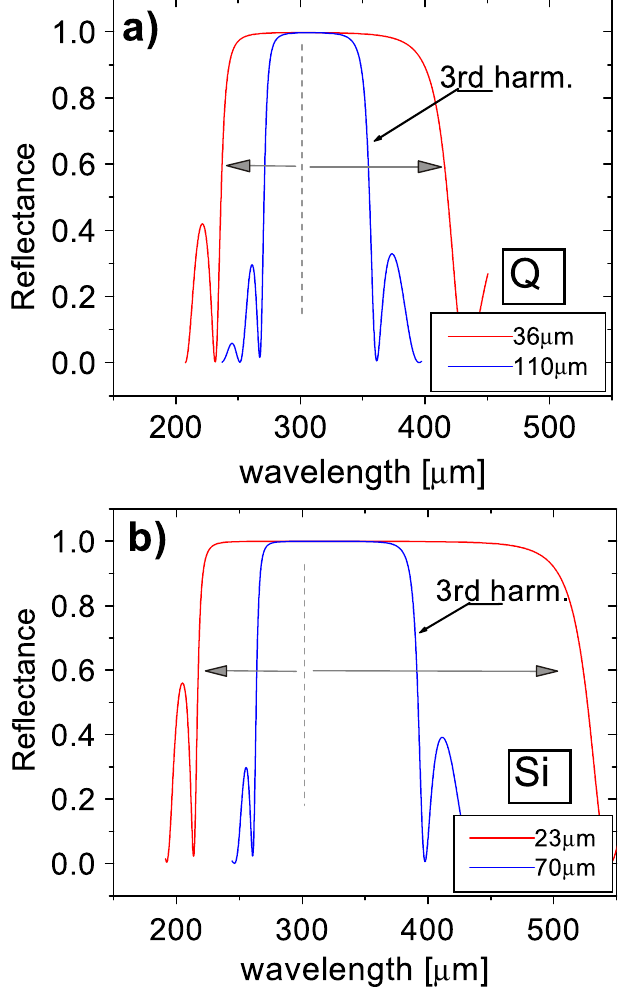
FIG. 11. (Color) Third harmonic band centers are shifted to- wards shorter or longer wavelengths by varying the spacing (initially 75 (cid:6) m ) between each quartz layer ( 110 (cid:6) m thick) in (a) and Si layer ( 70 (cid:6) m thick) in (b). Note that the respective fundamental HR band (not shown here) of the third harmonic band gap extends from (cid:1) 800 (cid:6) m to well over 1000 (cid:6) m for the Q PhC ( (cid:1) 750 – 1300 (cid:6) m for the Si